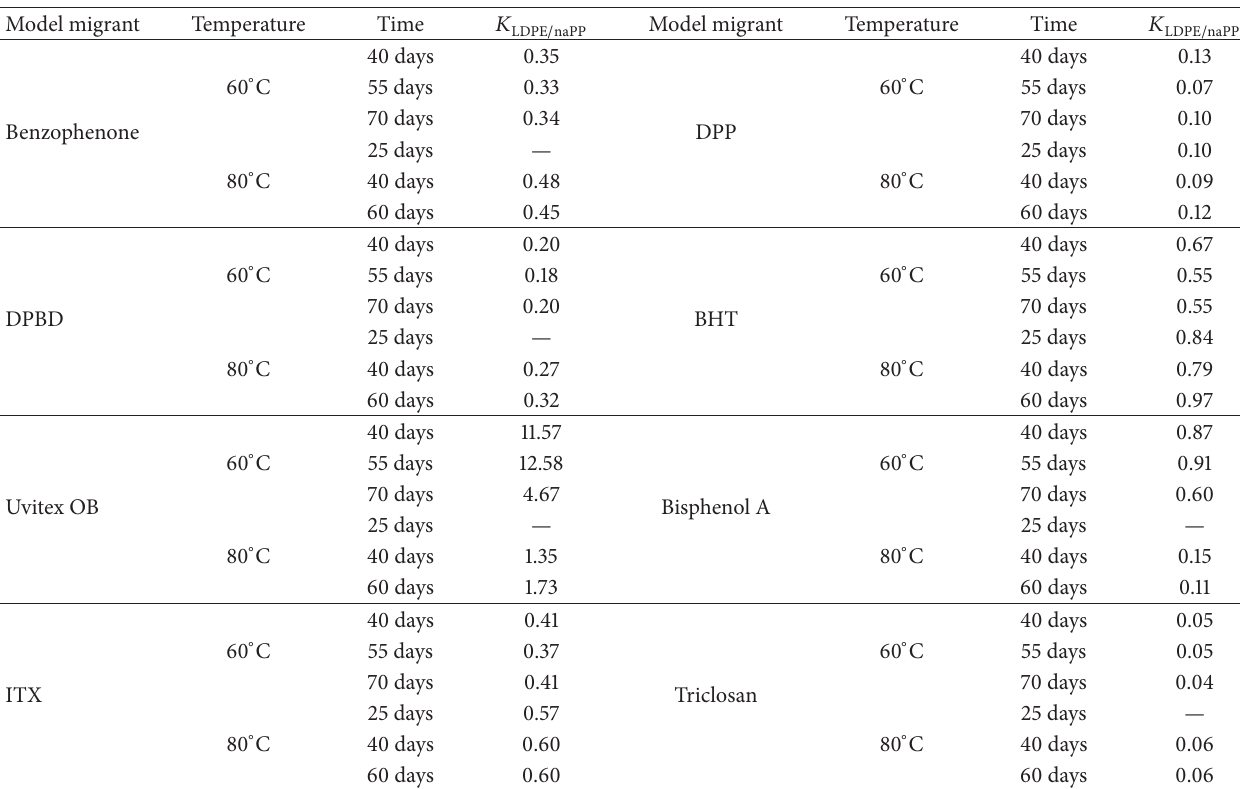
Table 6: Partition coefficient of polyethylene/nanocomposite polypropylene ( 𝐾 LDPE / naPP ) at 60 ∘ C and 80 ∘ C for all substances studied. Model